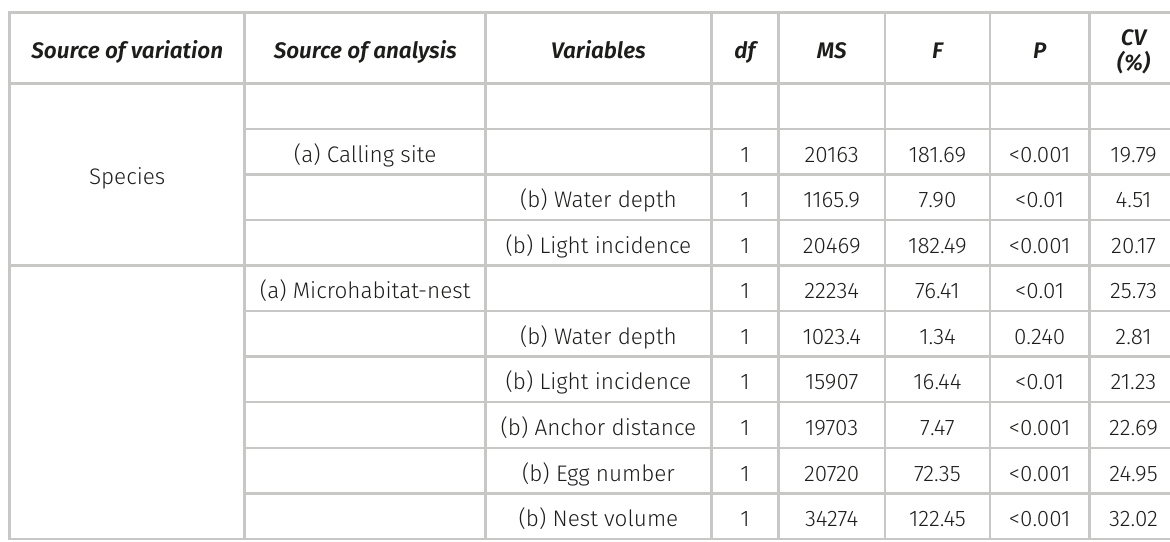
Table II. Permutational (a) MANOVA and (b) ANOVAs based on the Bray–Curtis similarities of the multivariate data on calling sites and microhabitat-nest variables from P. aff. albonotatus and P. santafecinus . The component of variation (CV) attributable to each source of variation is also